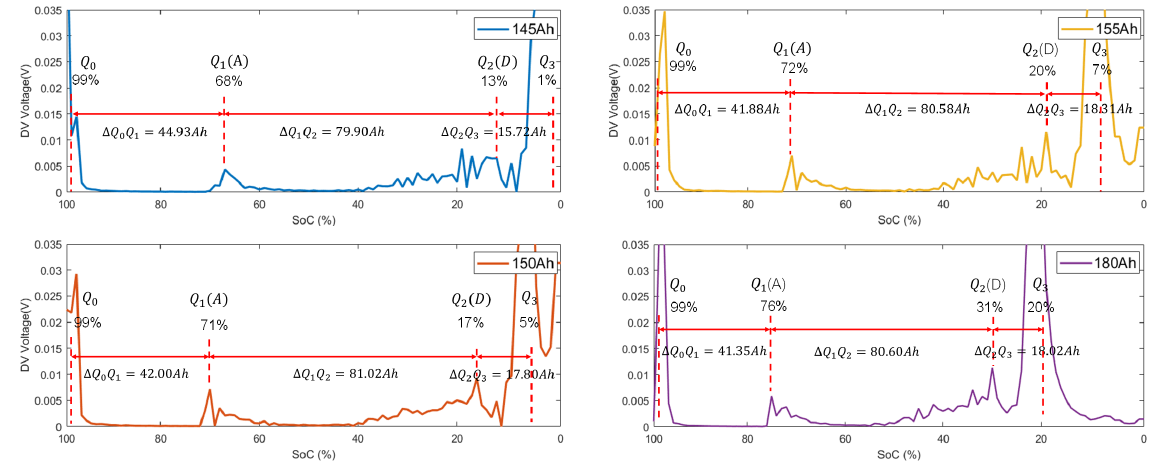
Figure 14. Experimental results under different battery capacities.